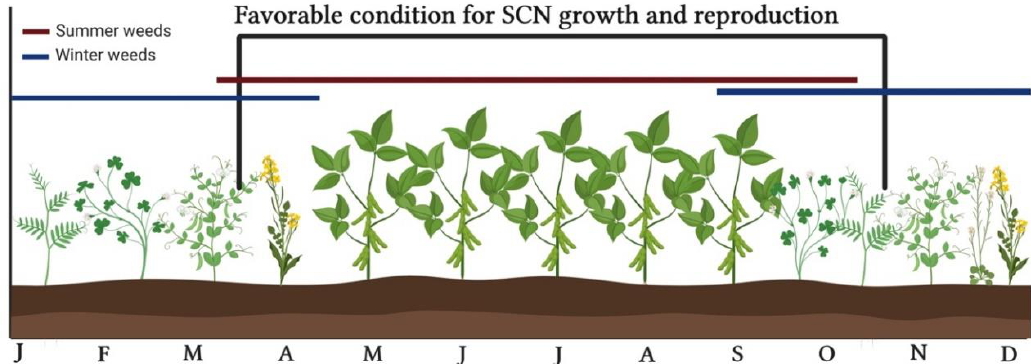
Figure 2. Dynamics of SCN and winter annual weeds in soybean cropping systems. Adapted from [37]. Created with BioRender ® (BioRender.com).